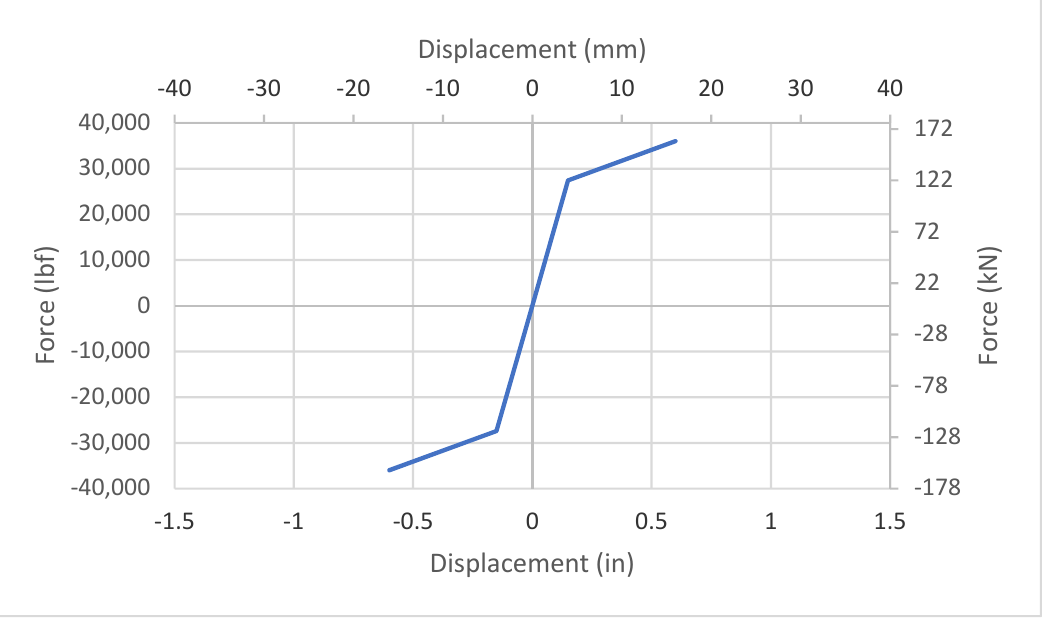
Figure 18. Bilinear load-displacement response for vertical movement in MYZ connector—scaled for a 60% building size.